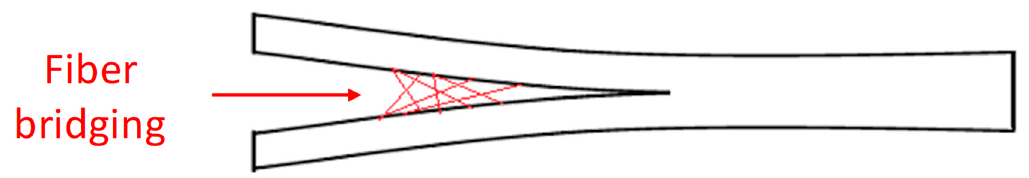
Figure 1. Fiber bridging schematic representation.